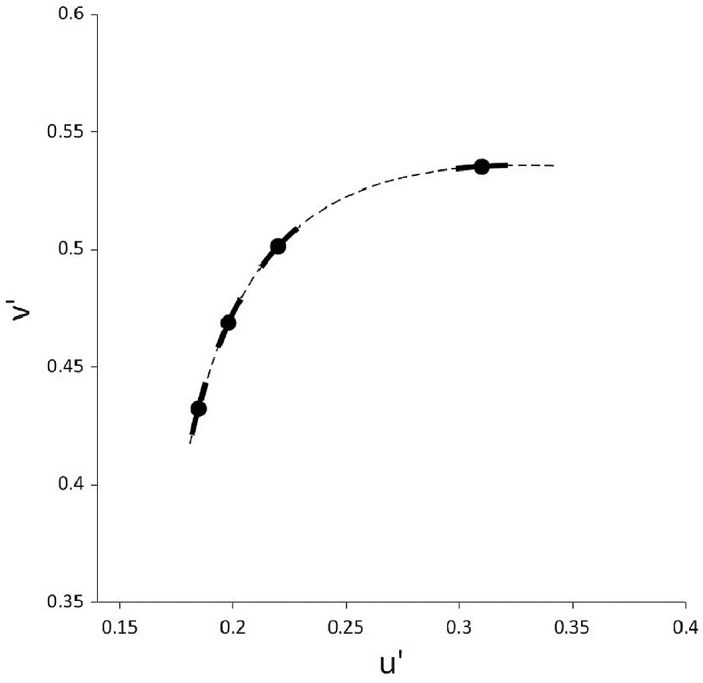
Data of Figure 2b represented in the CIE UCS diagram. The CIE u’ v’ chromaticities of the four base lights correspond to the black dots. The dashed line represents the daylight locus and the thick black lines emerging from the base points represent the full range of daylight change tested for each base light.